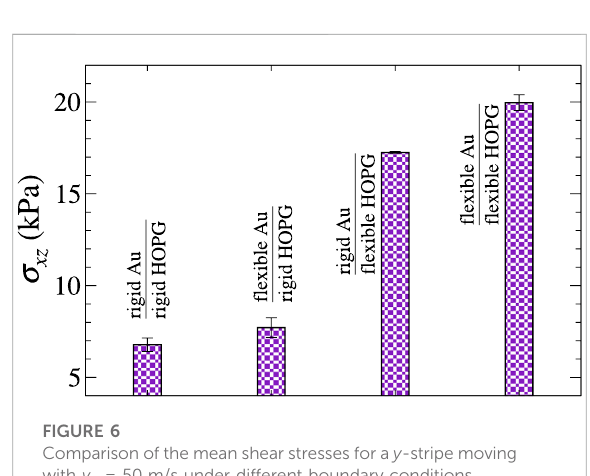
FIGURE 6 Comparison of the mean shear stresses for a y -stripe moving with v ⊥ = 50 m/s under different boundary